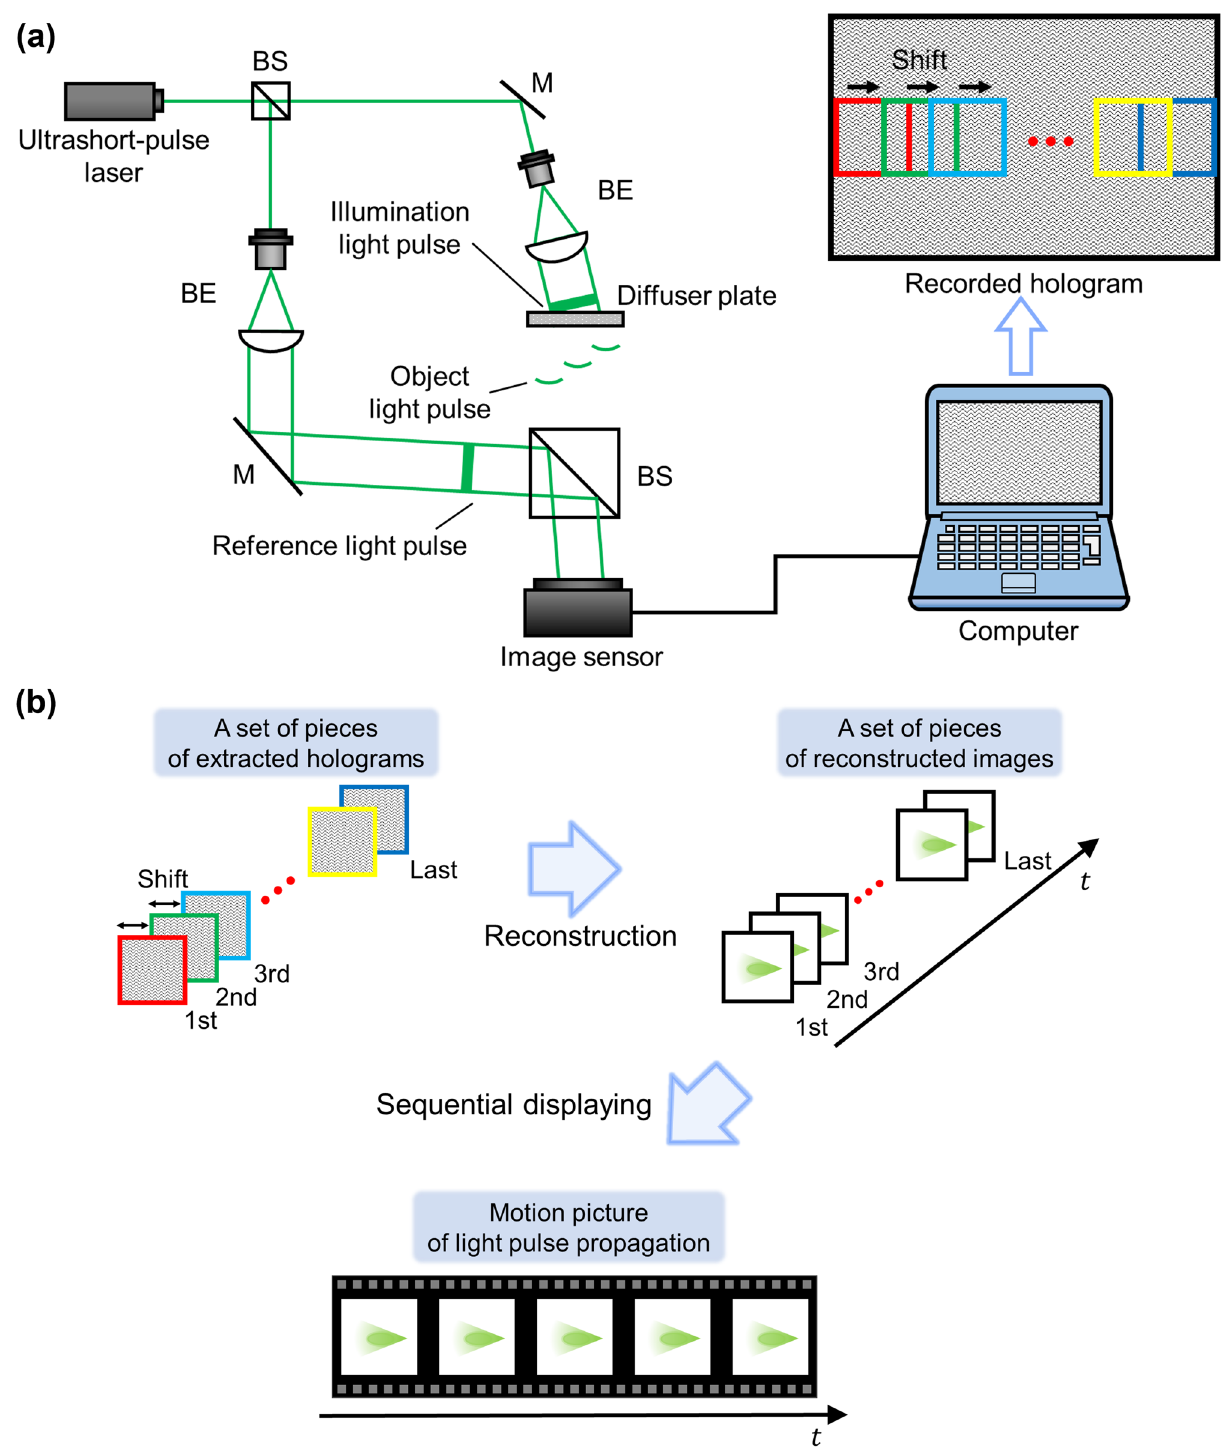
Figure 1. Schematic diagrams of the basic setups for DLIF holography. ( a ) Set-up for recording. BS, beam splitter; M, mirror; BE, beam expander. ( b ) Set-up for reconstruction. Figure 1 was originally created by the authors with PowerPoint for Microsoft 365 (https:// www. micro soft. com/ en- us/ micro soft- 365/ power